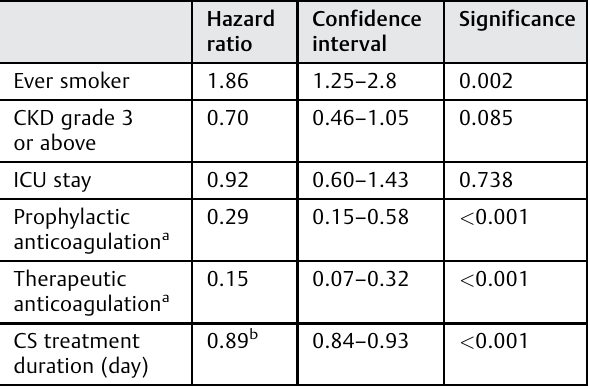
Table 2 Multivariate Cox proportional hazards model (all patients, n ¼ 127) Hazard Confidence